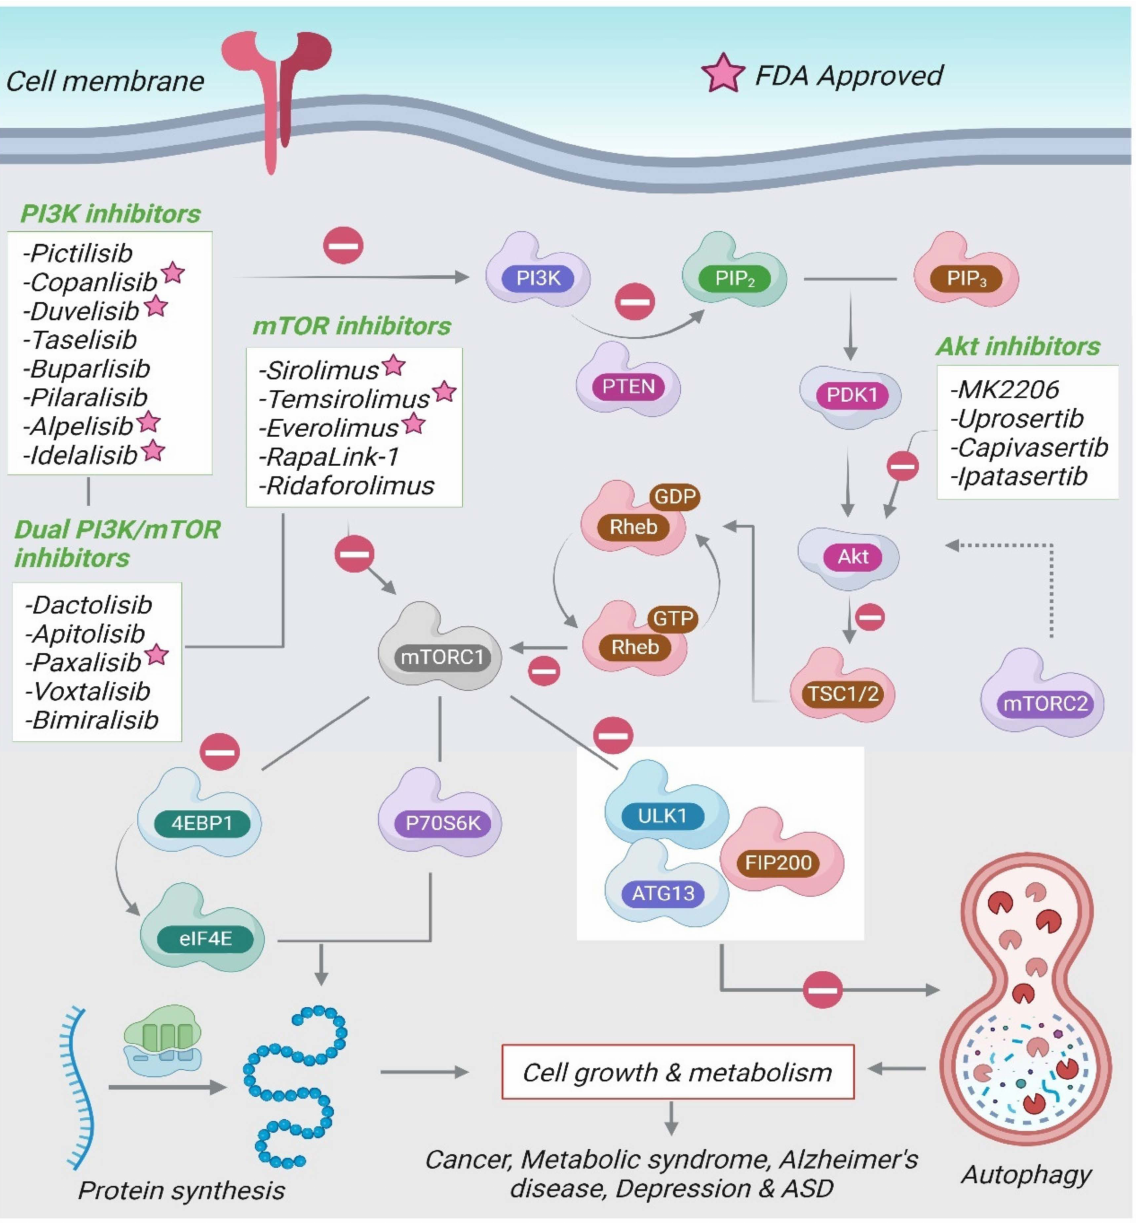
Figure 3. The drugs modulating the PI3K/Akt/mTOR